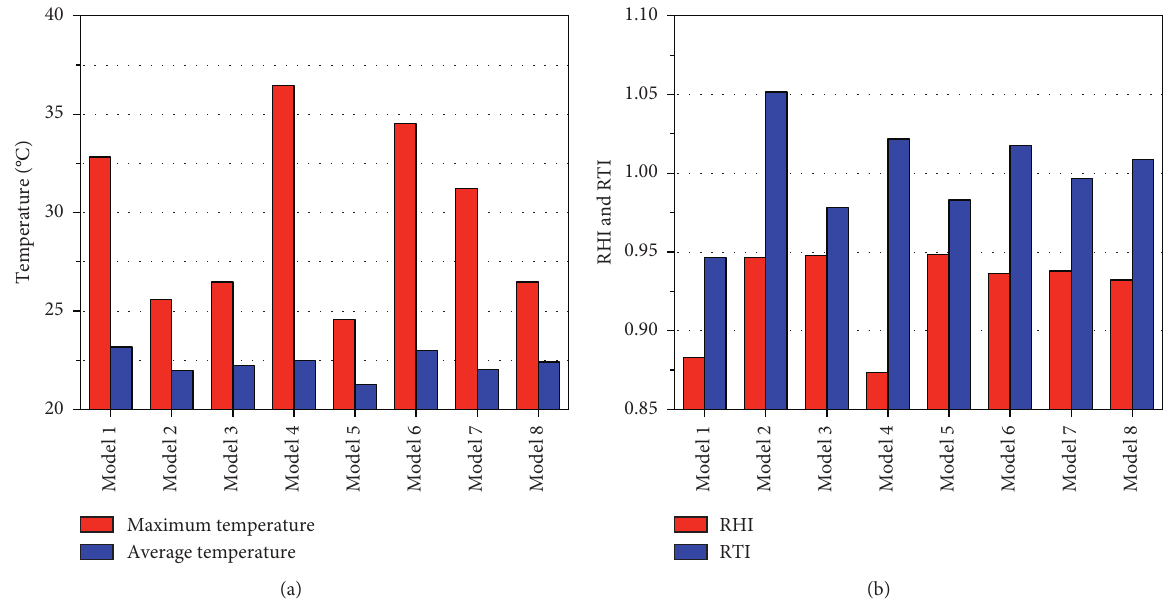
Figure 6: Evaluation based on temperature, RHI, and RTI of eight cases. (a) Temperature of thermal environment. (b) RHI and